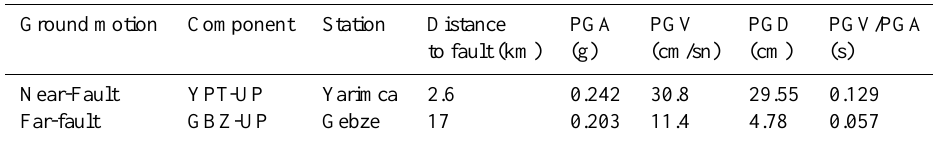
Table 2. Structural material and sectional properties of Bosporus Suspension Bridge (Adanur, 2003). Members Elastic modulus Cables sectional Moments of Poisson’s Mass Density (kNm − 2 ) area(m 2 ) inertia (m 4 ) ratio (tonm − 3 ) Deck Hanger Backstay cable